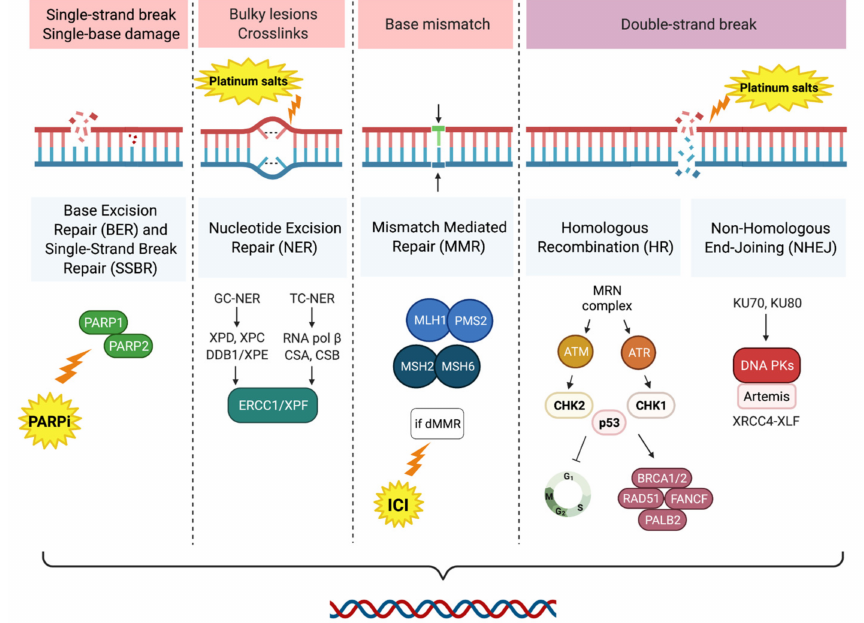
Figure 2. Schematic illustration of DDR pathways. Platinum compounds provoke intrastrand adducts and interstrand DNA crosslinks that can be repaired only by the activation of the NER, HR and NEHJ systems. PARPi inhibits the single-strand break repair mediated by BER and SSBR. Deficit in the mismatch repair leads to the increase of mutations and, consequently, neoantigens. This process is associated with a potential response to ICI. dMMR: deficit mismatch repair; HR homologous recombination; ICI: immune checkpoint inhibitor; NER: nucleotide excision repair; NEHJ: non-homologous end joining; PARPi: PARP inhibitor; SSBR, single-strand break